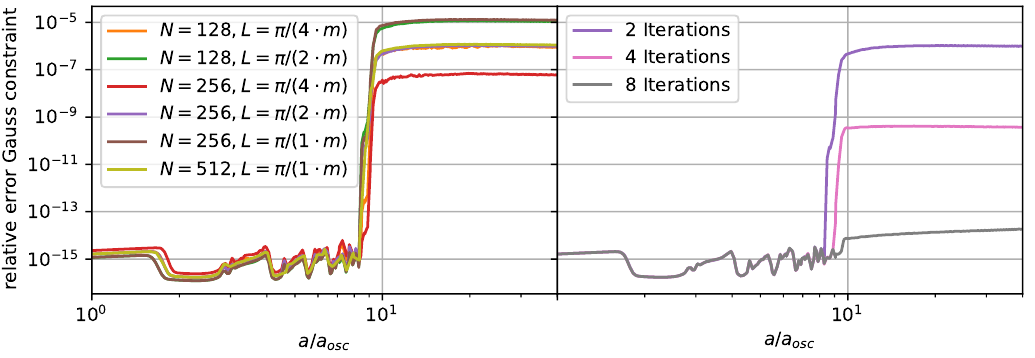
Figure 9: Evolution of the relative error in the Gauss constraint Eq. (43) for different choices of the number of lattice sites along each direction N and the side length of the simulated box L with fixed α = 60, θ = 1. The number of iterations used in the implicit scheme is fixed at 2 for the left panel while it is varied in the right panel with N = 256, L = π/ ( 2 · m ) held fixed. In all cases, the error stays close to machine ≈ 8, when the dark photon production backreacts on precision ≈ 10 − 16 up to a / a osc the axion. Thereafter, the error is minimized for small lattice spacings d x = L / N and a high number of